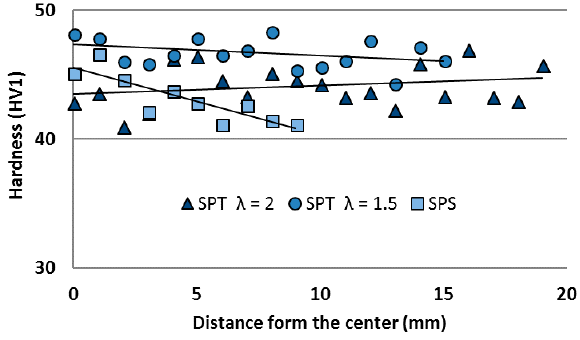
Figure 7. Hardness profile along part of the cross-section of AA6061/MLG 10 vol % composite.